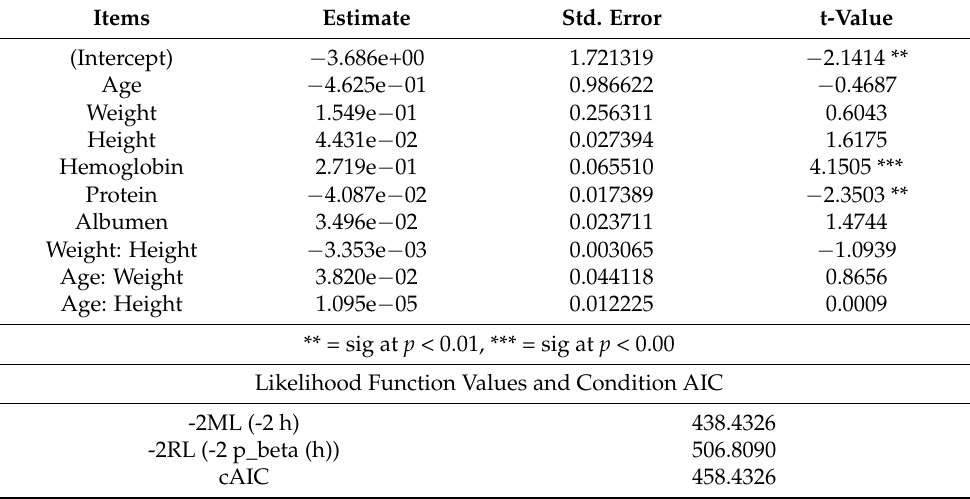
Table 6. Dispersion model estimates for Gaussian